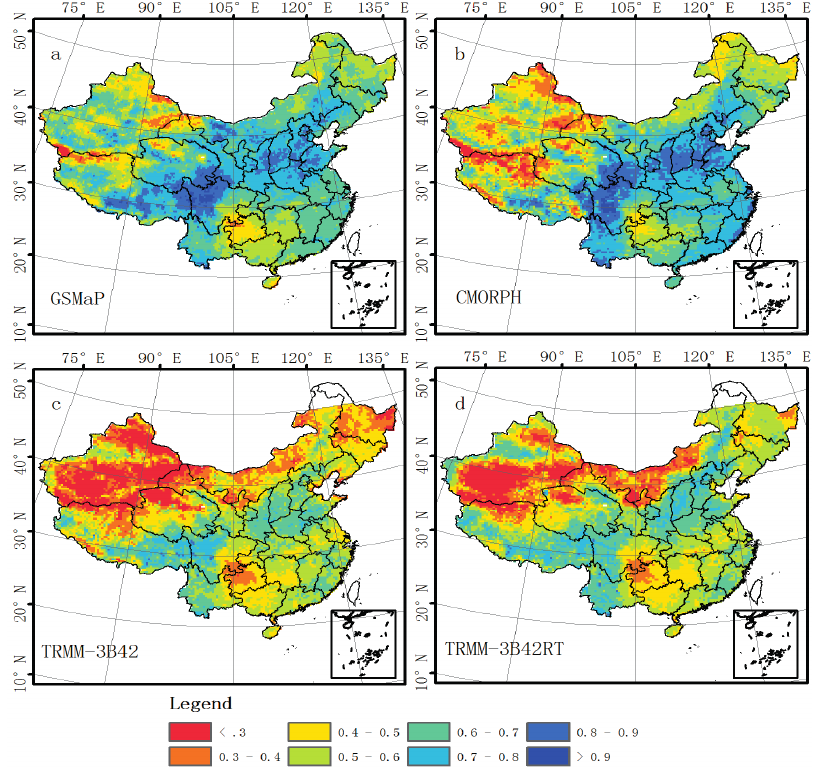
Figure 9. Distribution of POD over the Chinese Mainland from 2003 to 2006. ( a ) GSMaP,